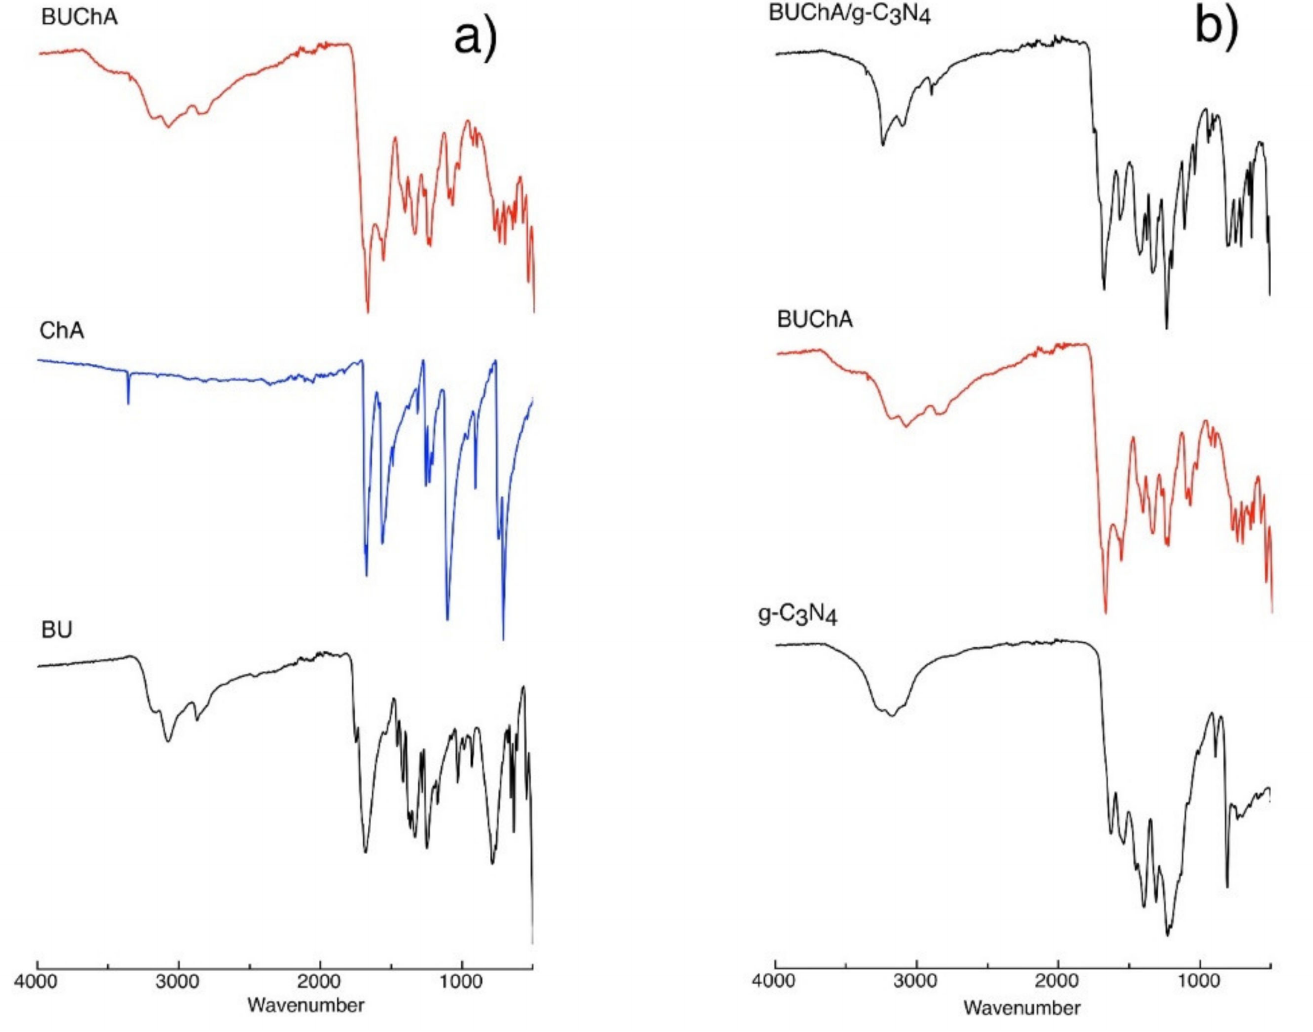
Figure 3. FTIR for the interaction between ( a ) BU and ChA and ( b ) immobilization of BUChA over g-C 3 N 4